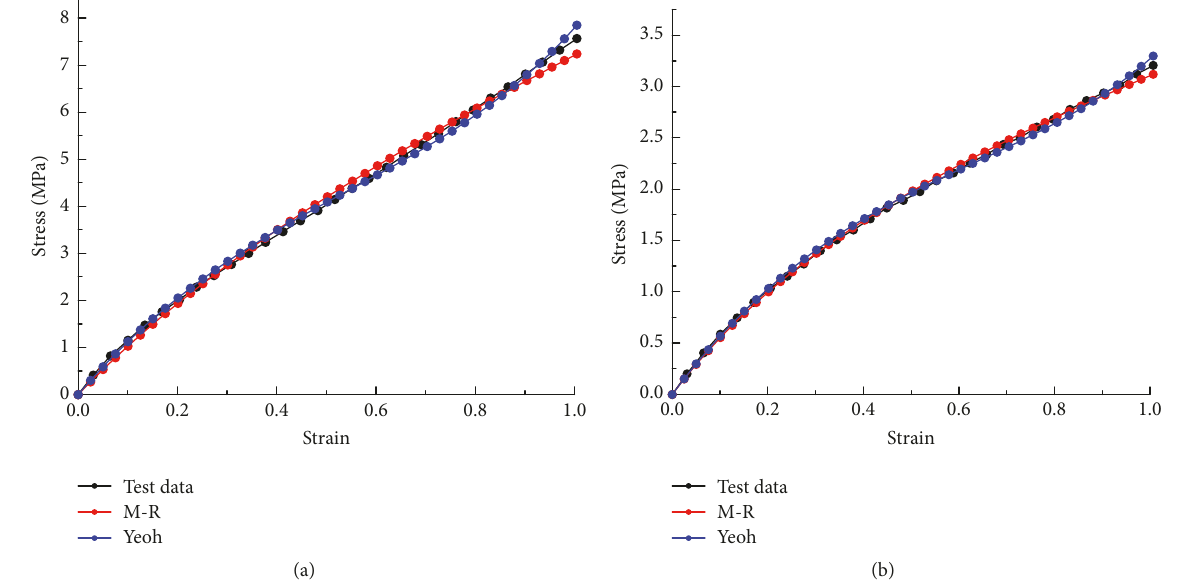
Figure 7: Stress-strain curve of rubber materials: (a) carcass rubber; (b) tread rubber.